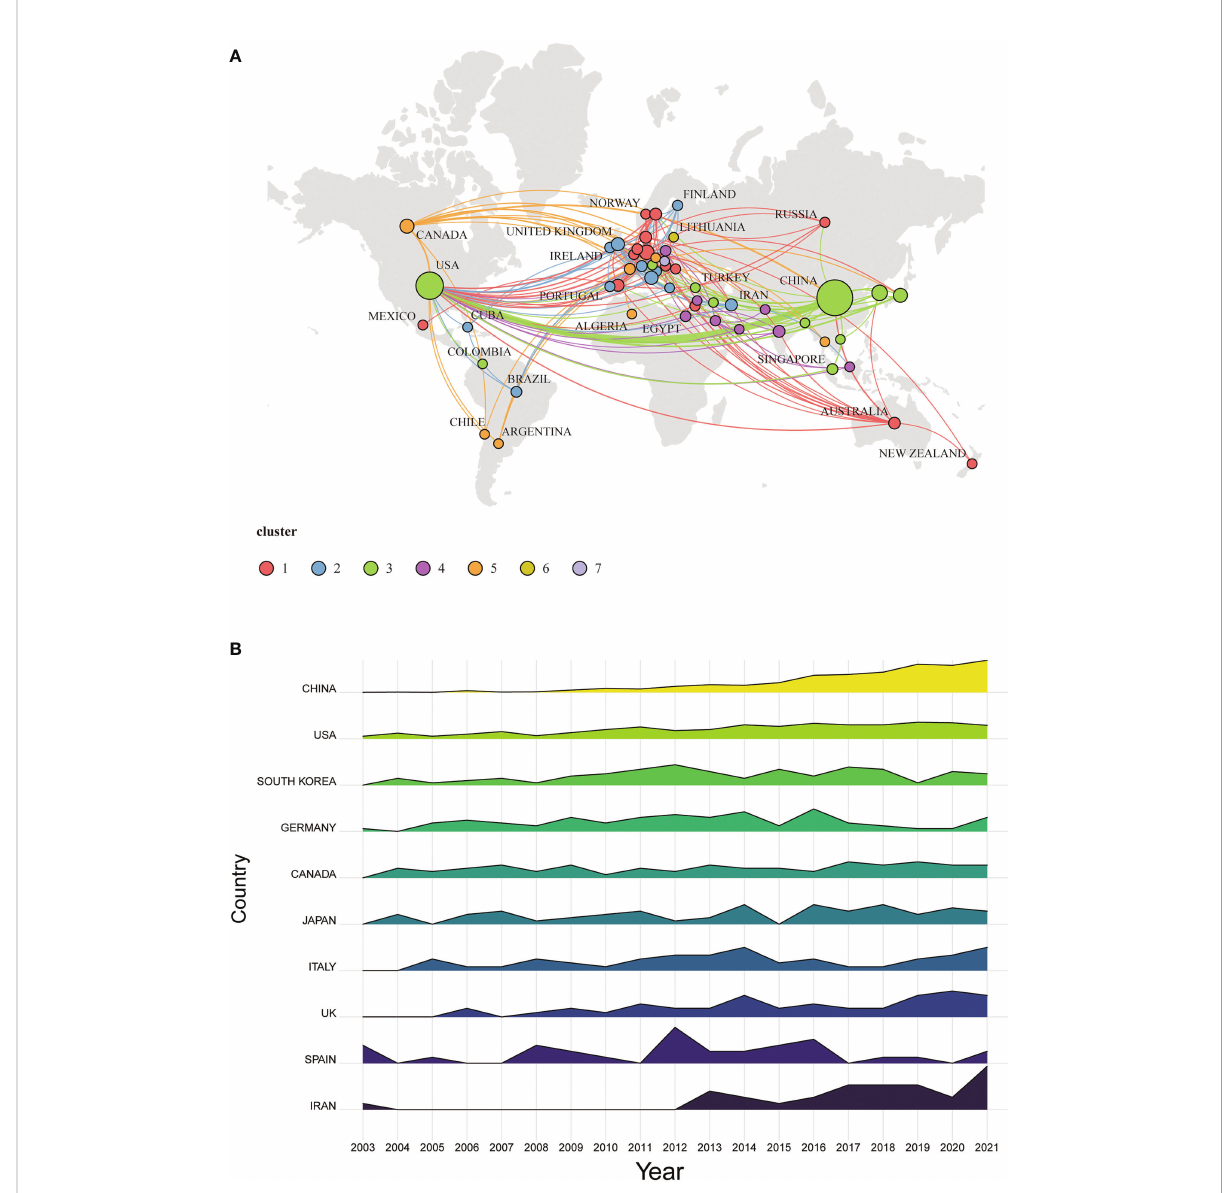
FIGURE 3 Country analysis. (A) Inter-country cooperation network map. The size of the nodes indicates the amount of publications, and the thickness of the lines represents the intensity of cooperation. (B) ridgeline